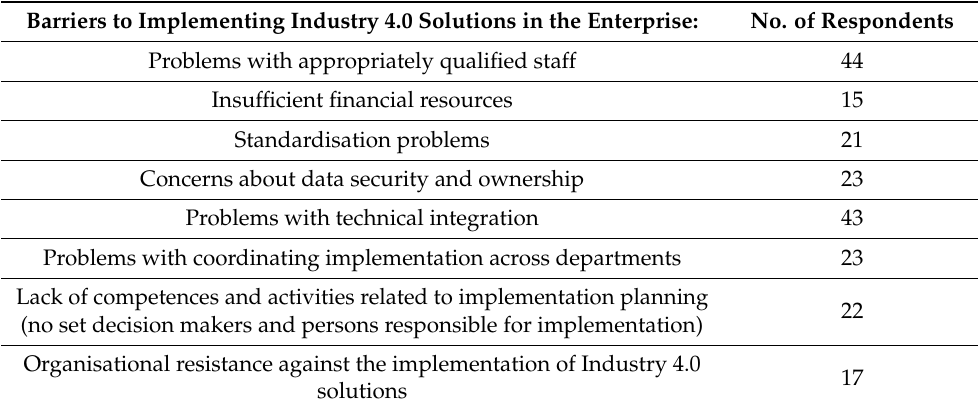
Table 5. Barriers to implementing Industry 4.0 solutions in the enterprise. Barriers to Implementing Industry 4.0 Solutions in the